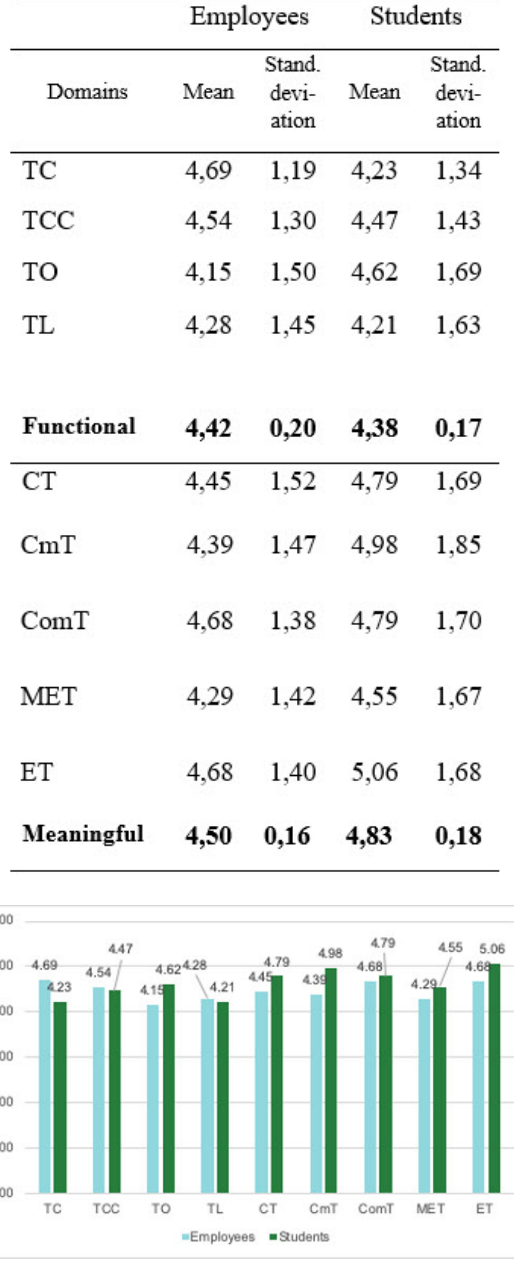
Figure 3. Comparison of